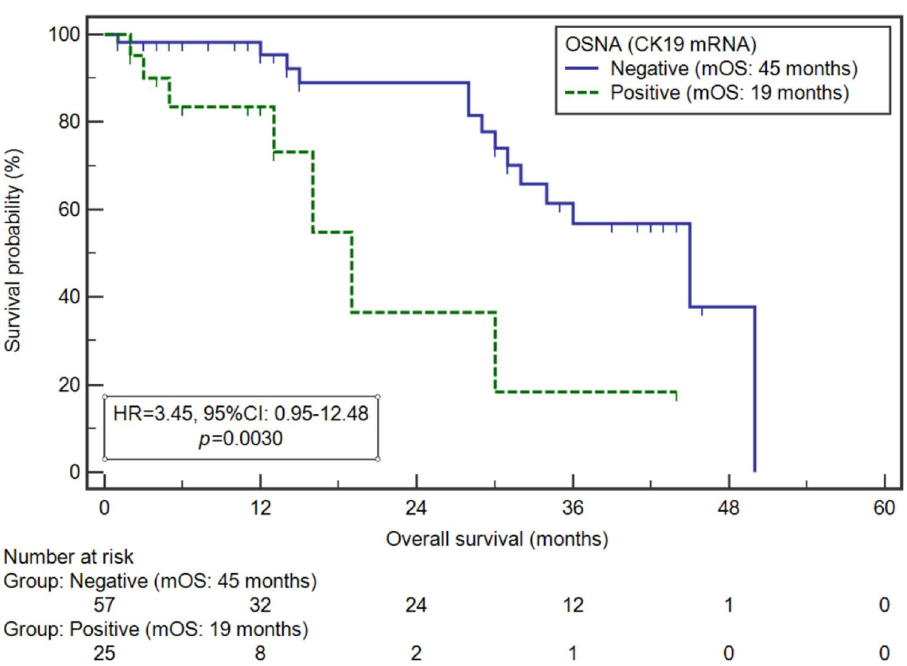
Figure 1. Kaplan–Meier curves representing survival probability depending on OSNA assay status in patients with advanced